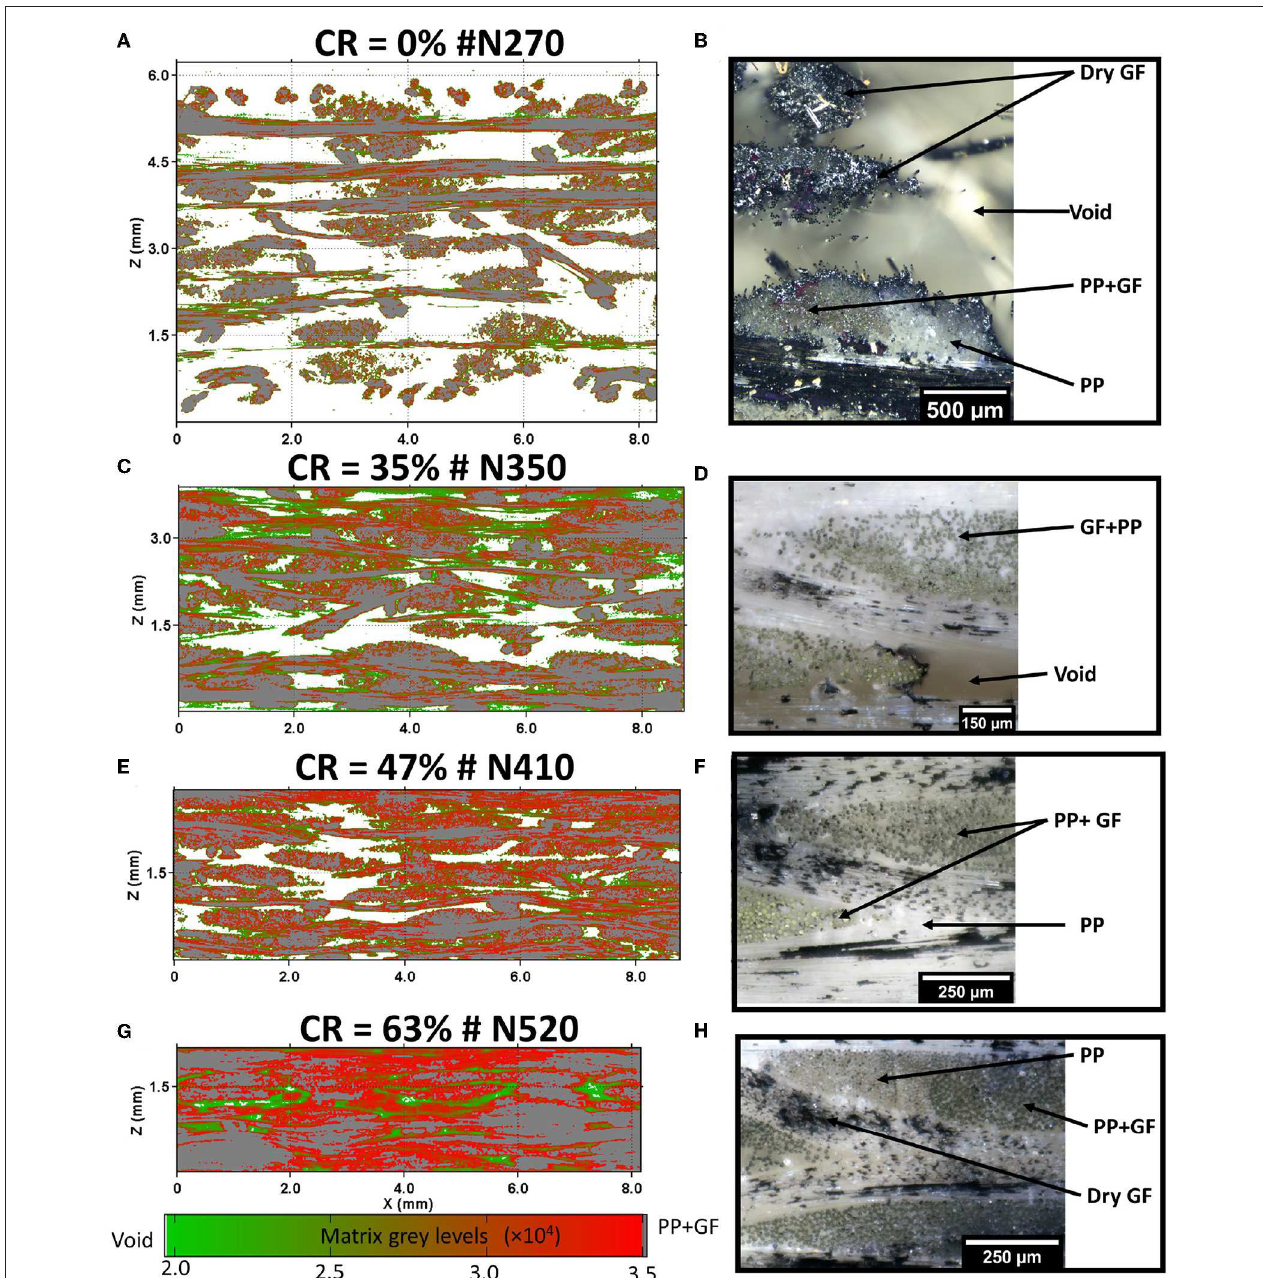
FIGURE 10 | (A,C,E,G) Color coded matrix voxels from µ CT 3D images which were segmented using the WCT method using the same scale bar. (B,D,F,H) Optical microscopy observations in the XZ plane of the composites samples.